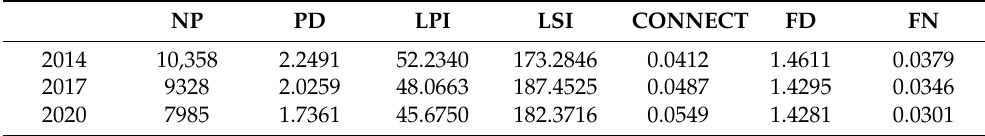
Table 4. Landscape pattern index calculation